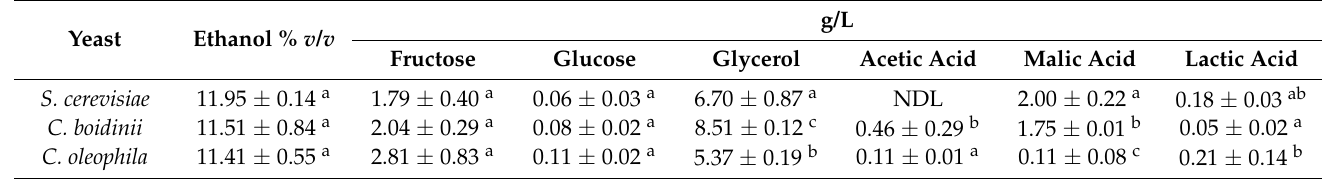
Table 7. Composition of Sauvignon Blanc wine obtained by sequential microvinification with grapes from the Curic ó (Maule,